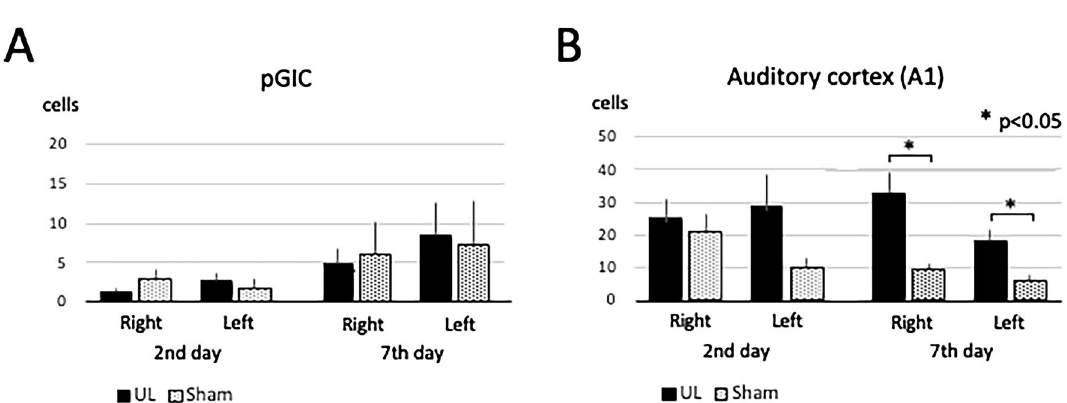
Figure 7. 3D ROI settings in pGIC and A1. ( A ) 3D ROI setting in the posterior granular insular cortex (pGIC) as a possible vestibular cortex. ( B ) 3D ROI setting in the primary auditory cortex (A1). Only the left hemisphere is shown because showing both hemispheres would interfere with clarity due to image overlapping.